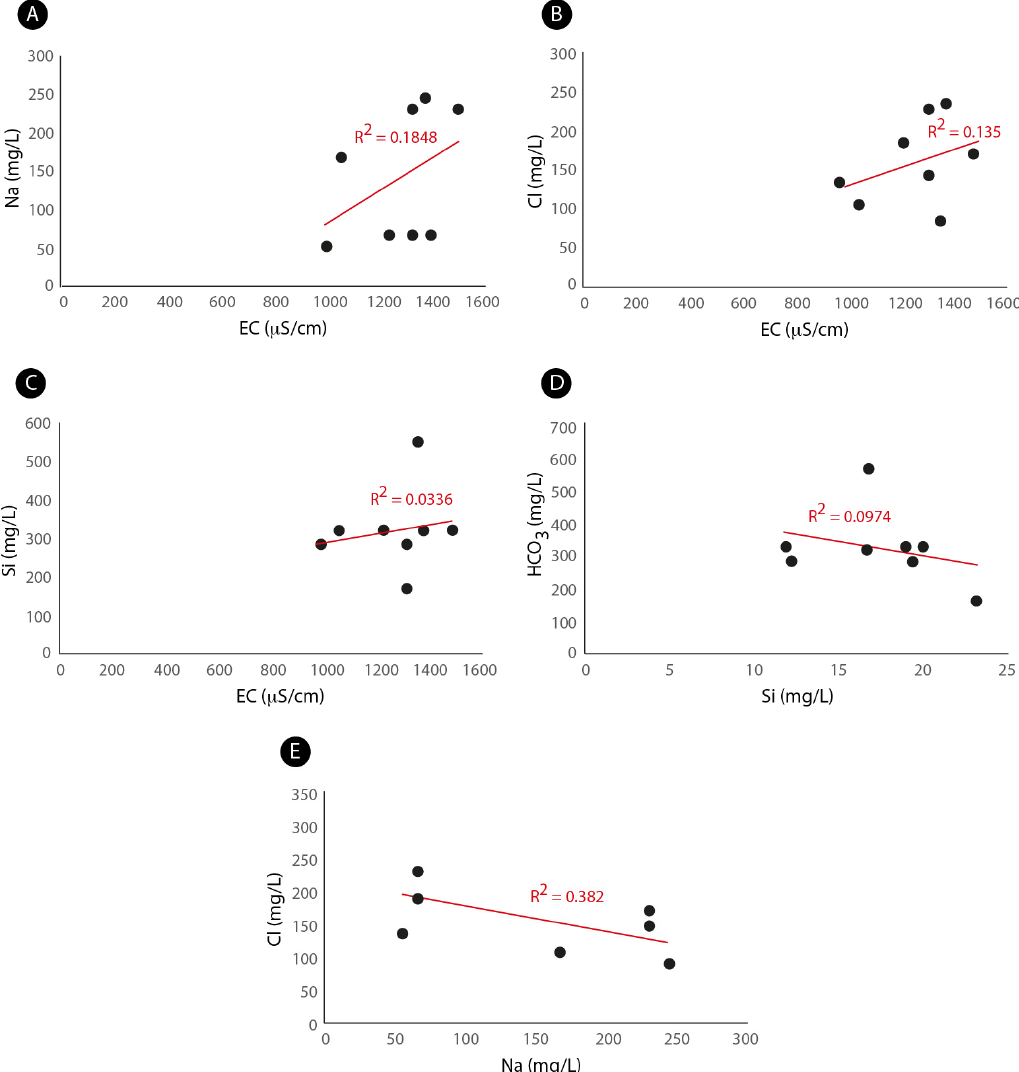
Figure 11. Relations between electrical conductivity (EC) and major ions in the Ribeira Seca river sub-basin. ( A) EC–Na; ( B) EC–Cl; ( C) EC–Si; ( D) Si–HC0 3 ; ( E) Na–Cl.